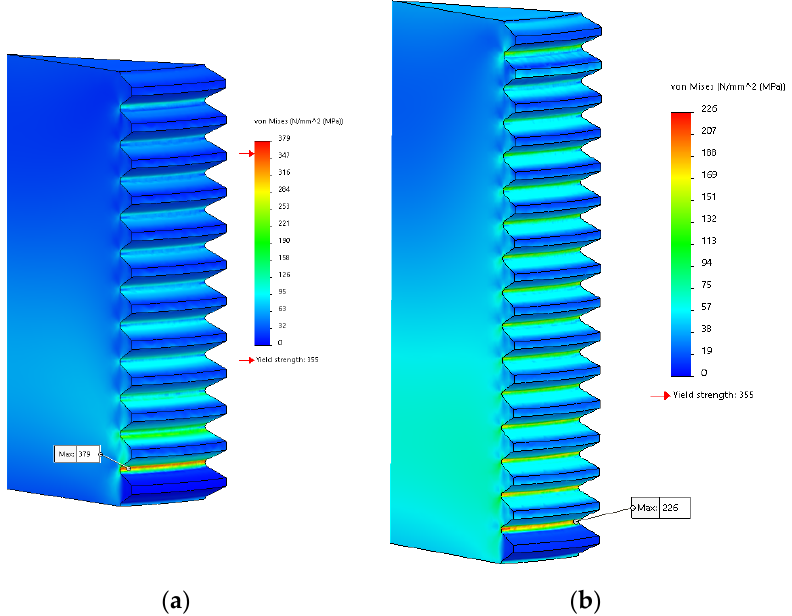
Figure 7. Fields of equivalent stress around the root of the first thread on the anchor bolt when using: ( a ) normalised nut; ( b ) designed nut.